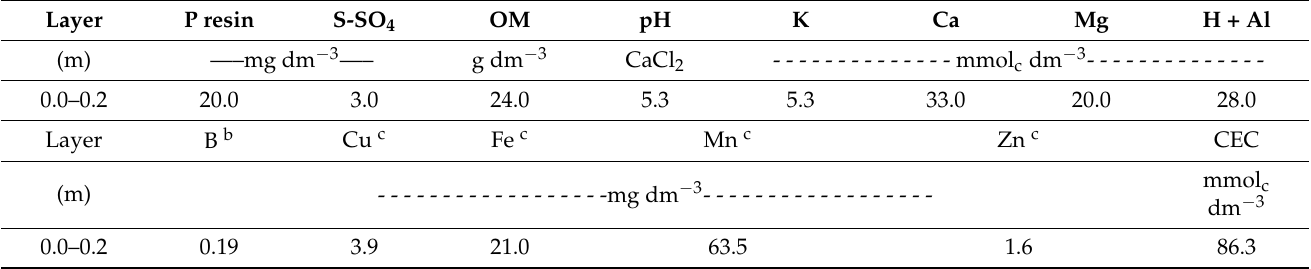
Table 1. Initial soil chemical characterizations a of the experimental area in the 0.0–0.2 m